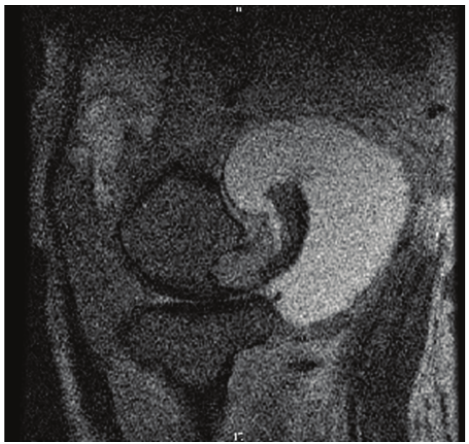
Figure 3: Suprapatellar and posterior knee effusions are visualized with MRI.